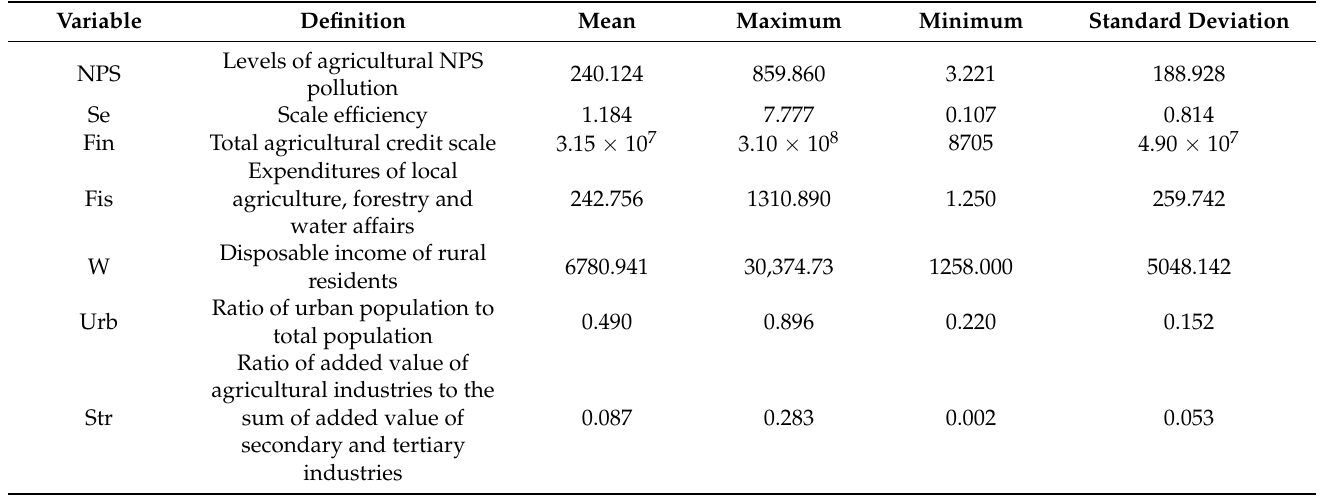
Table 1. Definitions and summary statistics of the variables used in the analysis.